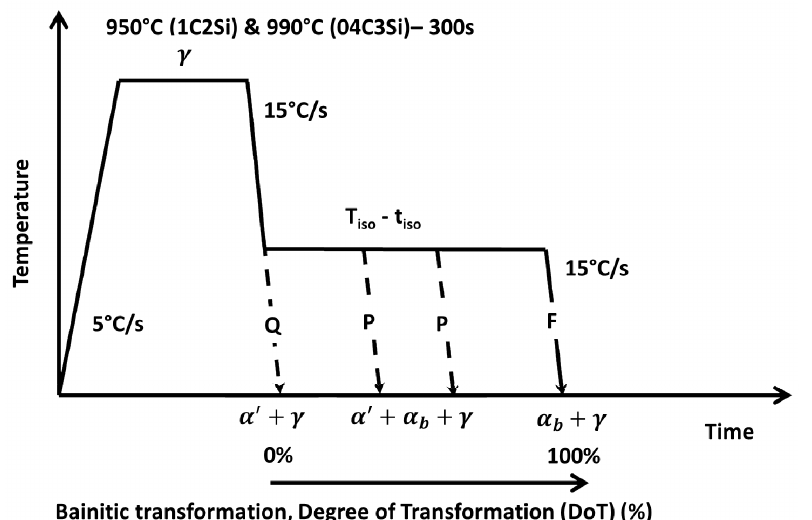
Figure 1. Scheme of the heat treatments applied in this work. Q stands for quench; P and F stand for partial and full transformation, respectively. The expected phases at relevant stages of the treatment are also indicated, where γ , α b and α (cid:48) stand for austenite, bainitic ferrite and martensite, respectively.